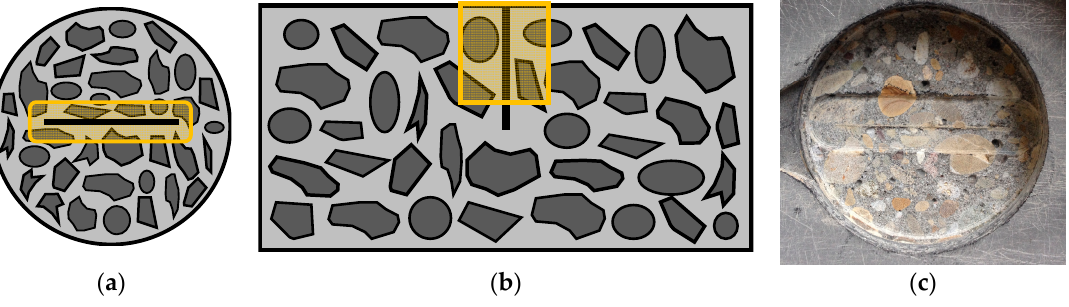
Figure 2. ( a ) Schematic top view of the 16 mm × 78 mm zone around the crack that was ground off; ( b ) schematic side view of the material ground away around the crack; and ( c ) top view of a specimen where a 2 mm thick layer of concrete was ground away around the crack.